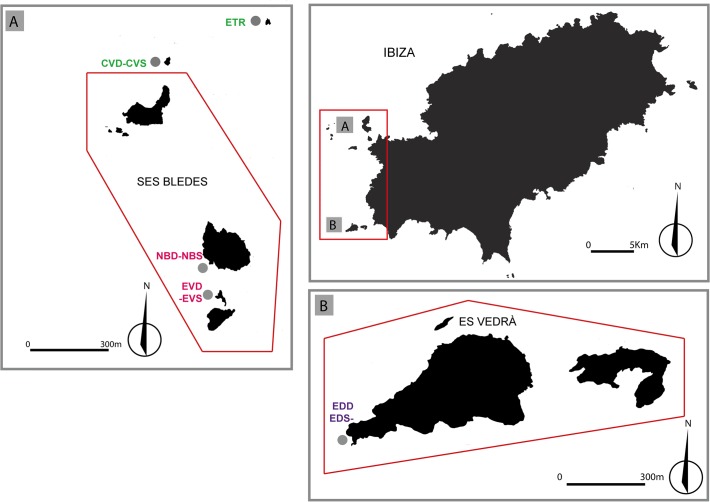
Sampling locations of the populations of Paramuricea clavata (grey dots) in Ibiza island.Populations sampled at the same location, but at different depths, are separated by an hyphen. Each population´s name is colored according to their assignment to the Structure clusters (K = 3). The islands inside the red lines in quadrants A and B conform the Nature reserves of Els Illots de Ponent (A), and Es Vedrà and Es Vedranell (B).